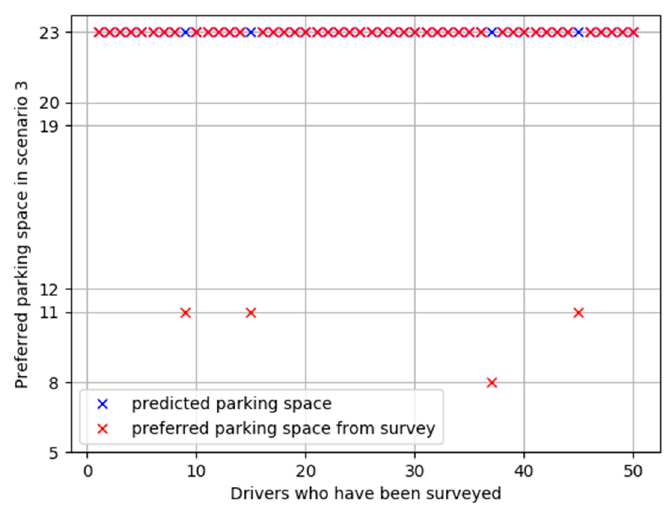
Figure 9. Comparison between the predicted parking space preference and the opinions of the most preferred parking space from fifty drivers in three example scenarios.